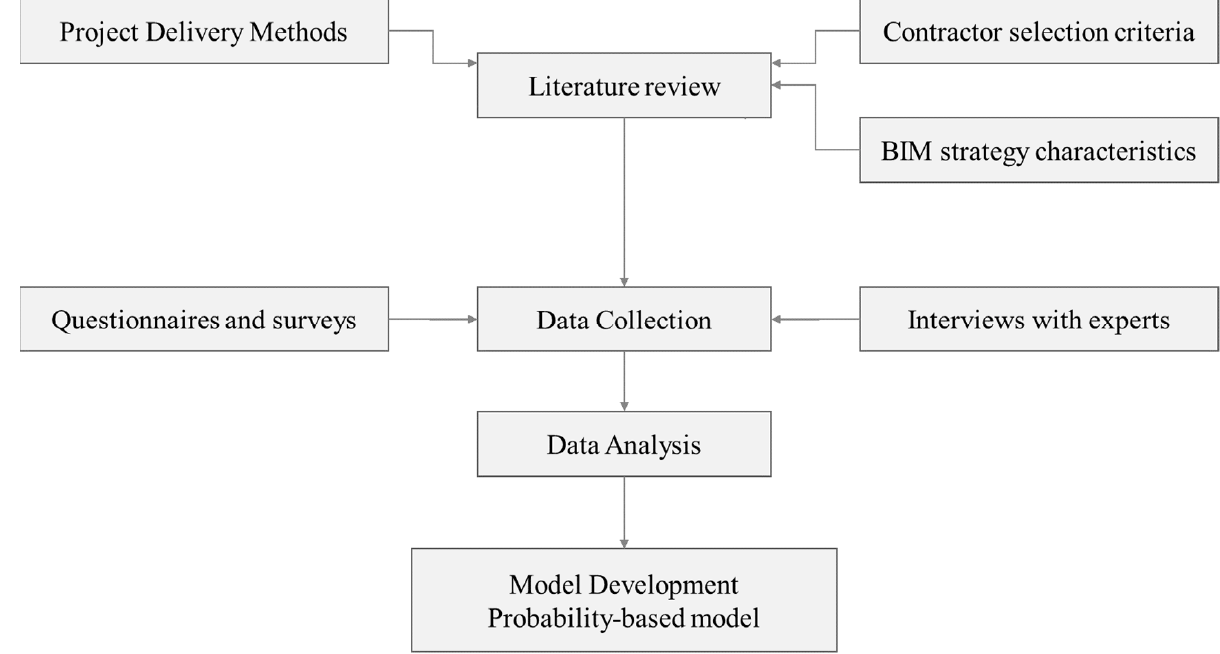
Figure 1. Research methodology.